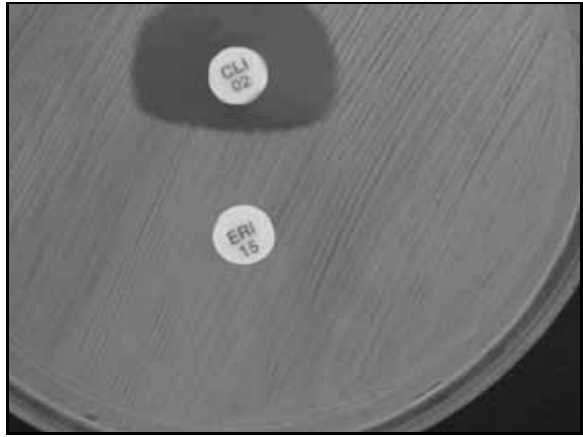
Figura 2 – D teste: achatamento de halo de clindamicina demonstrando resistência induzível Fonte: Caio Roberto